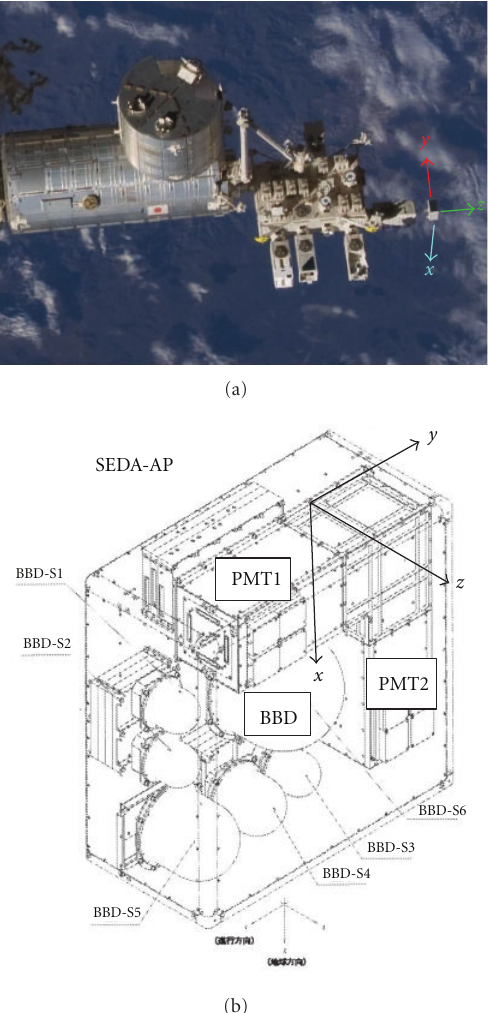
Figure 3: (a) The photograph of Japan Exposure module onboard the International Space Station. The coordinate of the FIB sensor is drawn on by the blue arrows ( x coordinate blue, y coordinate in red, and z coordinate by green), (b) An FIB sensor was mounted on SEDA-AP together with BBD. Proton tracks are measured by a photomultiplier (PMT2) that looks the scintillation fibers from the bottom side ( z - y plane), while for the x - z plane the other photomultiplier (PMT1) is used looking from the proceeding section of the ISS.